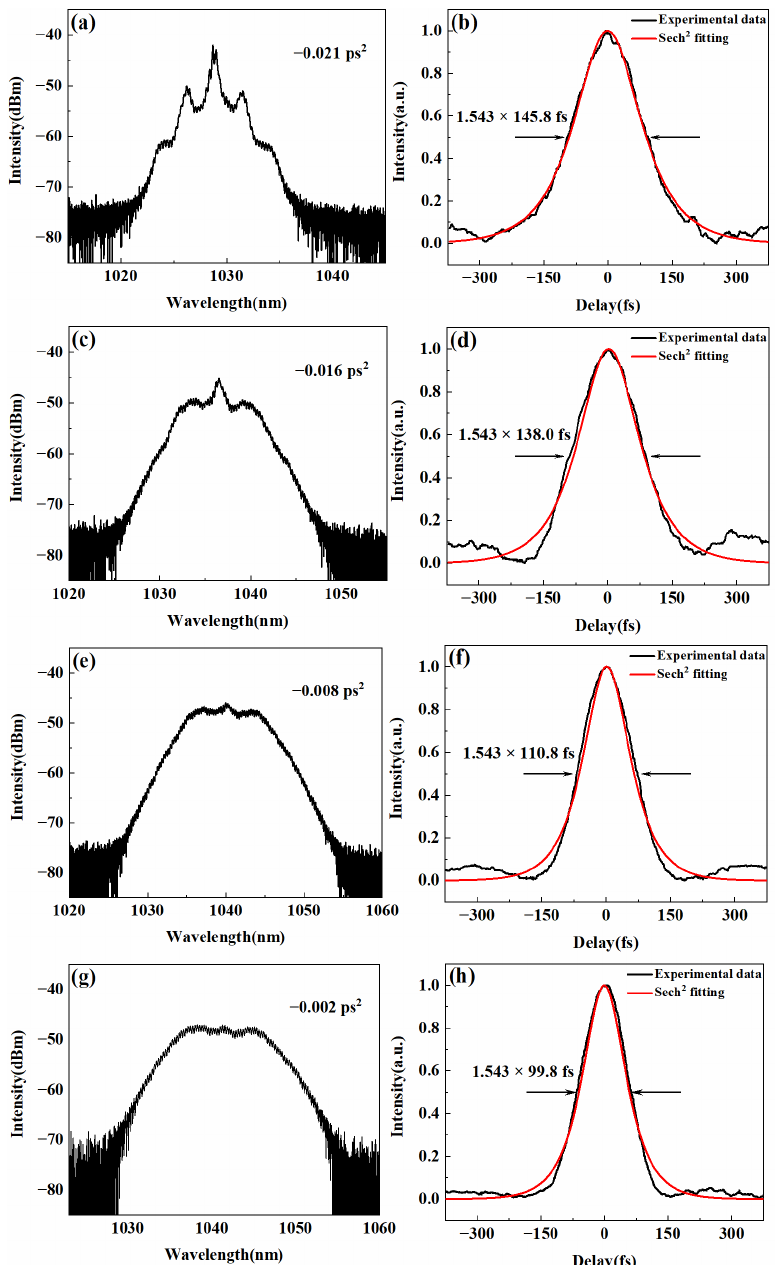
Figure 3. The evolution of optical spectra and pulse duration with the net inter-cavity dispersion tuning from − 0.021 ps 2 to − 0.002 ps 2 . The measured spectra are presented in logarithmic scales in ( a , c , e , g ). The corresponding autocorrelation traces of experimental (black) and sech 2 fitting (red) pulses are shown in ( b , d , f , h ).